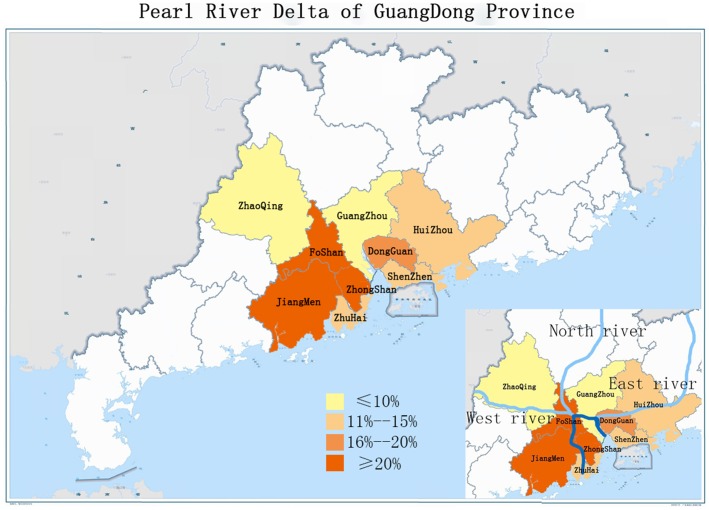
A map indicating the prevalence of HEV RNA in the Pearl River Delta of Guangdong Province.